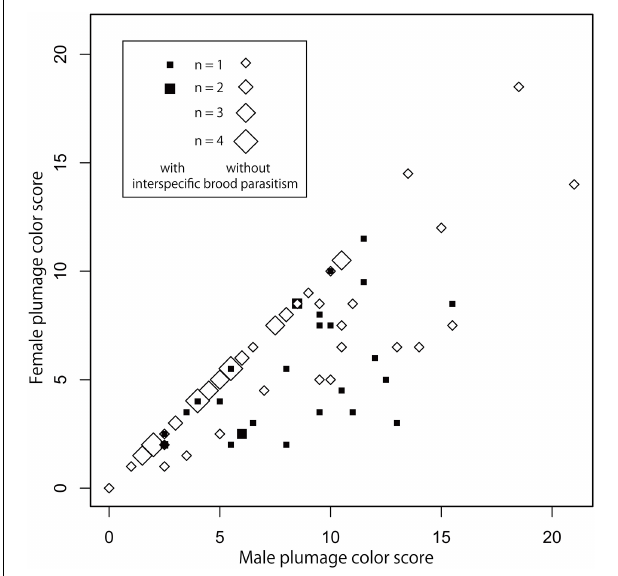
FIGURE 2 | Correlation of plumage coloration between sexes when interspecific brood parasitism is also considered (see Table 3). Each dot shows the scores of the coverage of ornamentally colored (i.e., red, black, and blue/purple) plumage areas in males and females of each species. Filled square dots stand for the species with intersecific parasitism (n = 27) while open dots for those without it (n = 58).